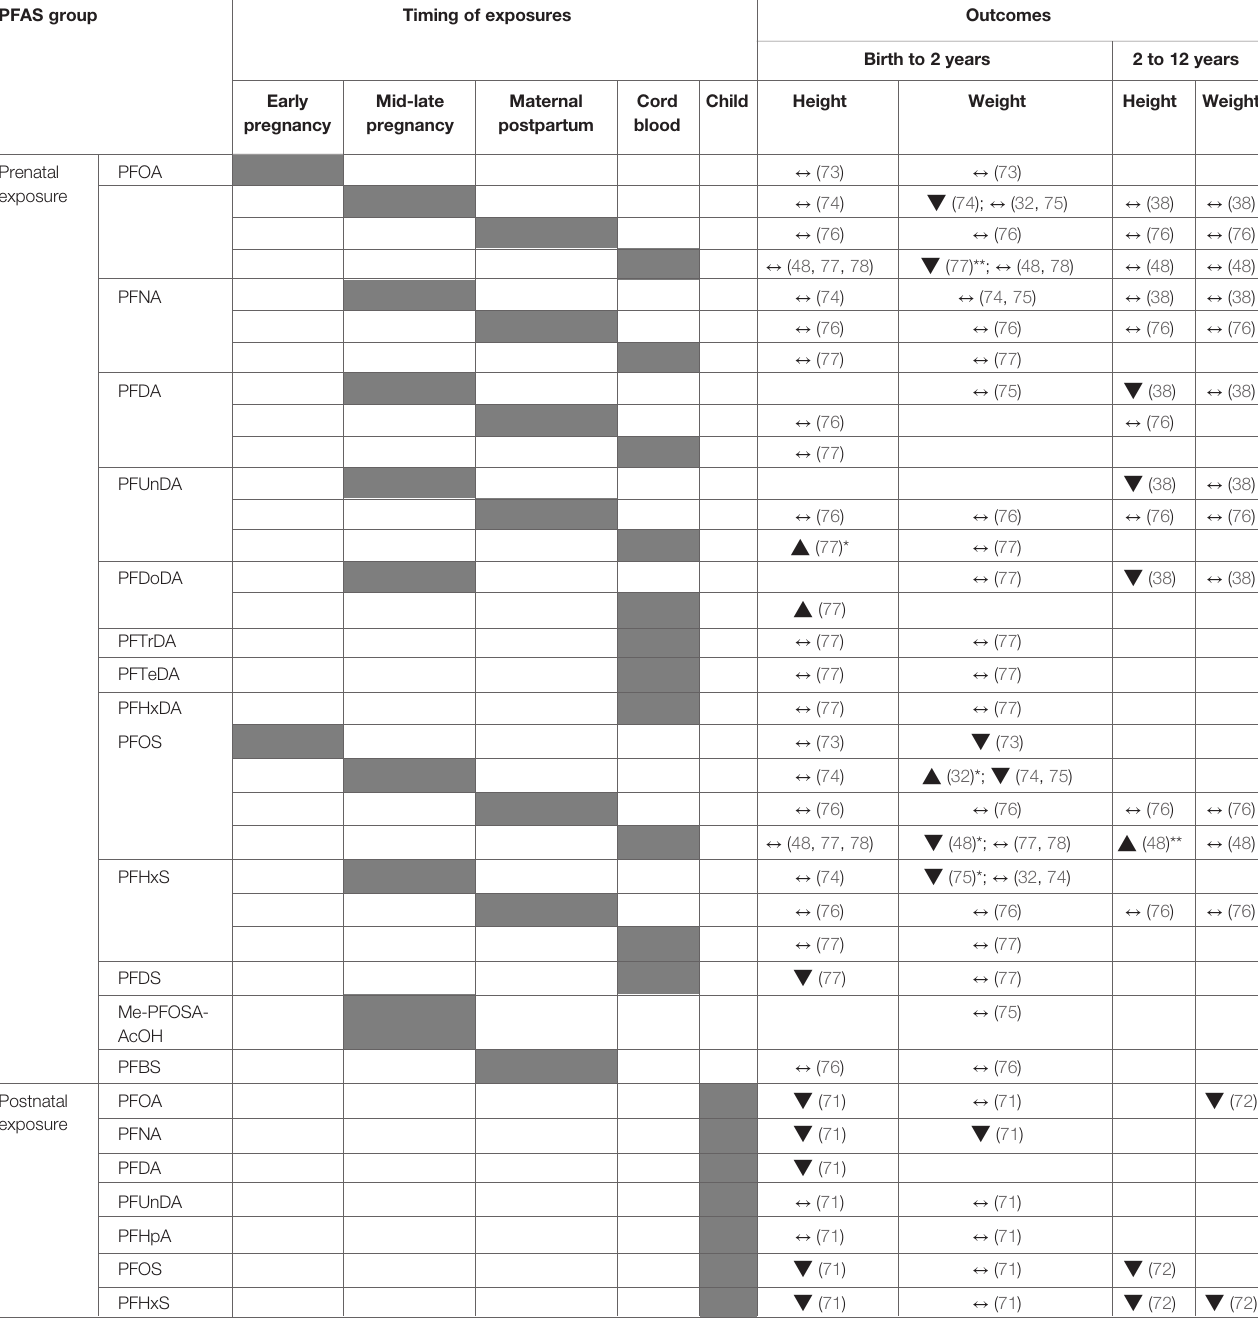
TABLE 2 | Summary of studies assessing associations between PFAS exposure and postnatal growth outcomes. PFAS group Timing of exposures Outcomes Birth to 2 years Early Mid-late Cord Child Height Weight Height Weight pregnancy pregnancy blood Prenatal exposure